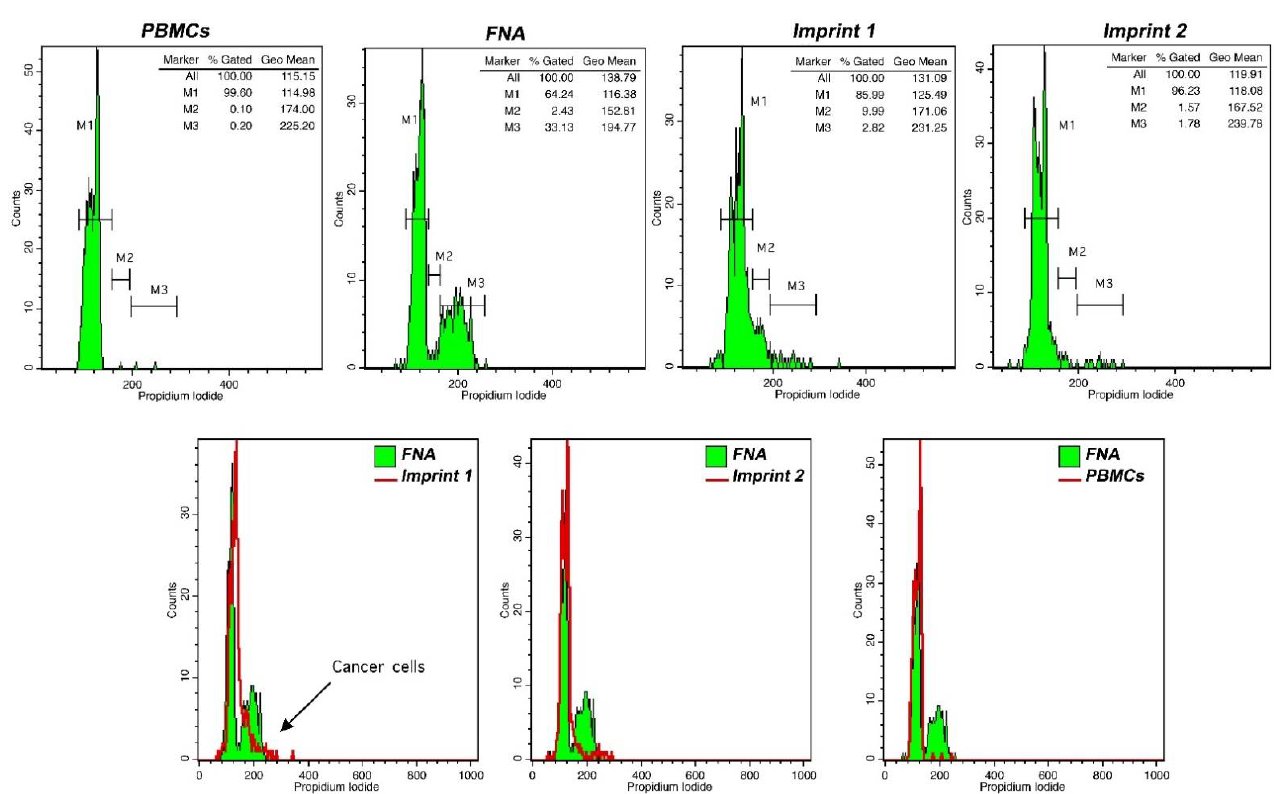
Figure 3. DNA analysis in touch imprint iFC. Peripheral blood mononuclear cells (PBMCs) were used as a control for DNA content evaluation. FNA samples were used to characterize malignant cells (in this case, cells with a tumor index of 35.5%). Imprint 1 represents a positive margin containing cancer cells, based on tumor index evaluation, while imprint 2 represents a negative margin. We used flow cytometry analyses in different imprints during surgery to characterize them for the presence of cancer cells. If an imprint from a patient contained cancer cells, the respective margin was indicated as positive.